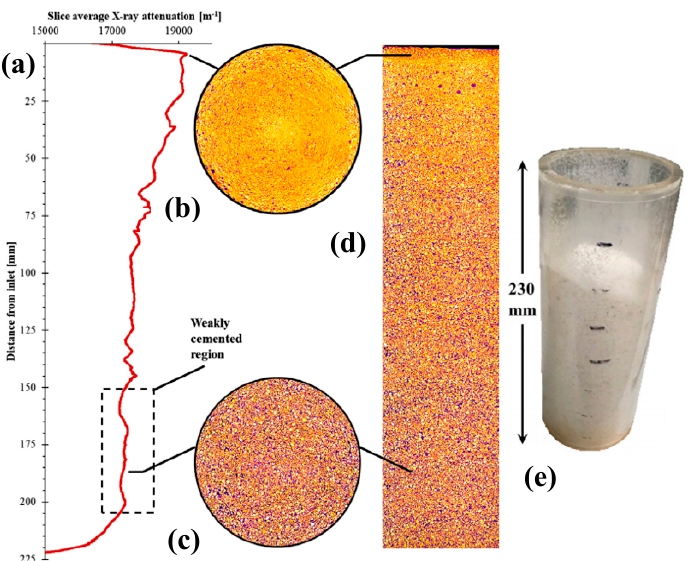
Figure 9. X-ray computed tomography (X-CT) column scans, showing in yellow-white colors high attenuation from solid material. Purple-black colors indicate low attenuation (e.g., air-filled pore space). ( a ) Slice averaged X-ray attenuation vs. distance from inlet column; ( b ) Maximum average attenuation; ( c ) Attenuation from the weakly cemented region; ( d ) Overall vertical profile attenuation; ( e ) Inverted column after non cemented sand removal. Adapted with permission from [79].